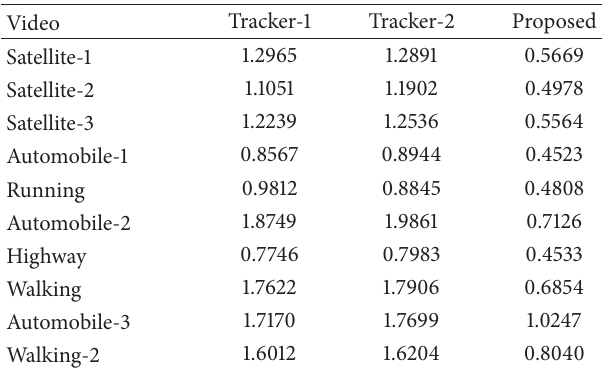
Table 3: Averaged Bhattacharyya distances for our proposed method, Tracker-1 , and Tracker-2